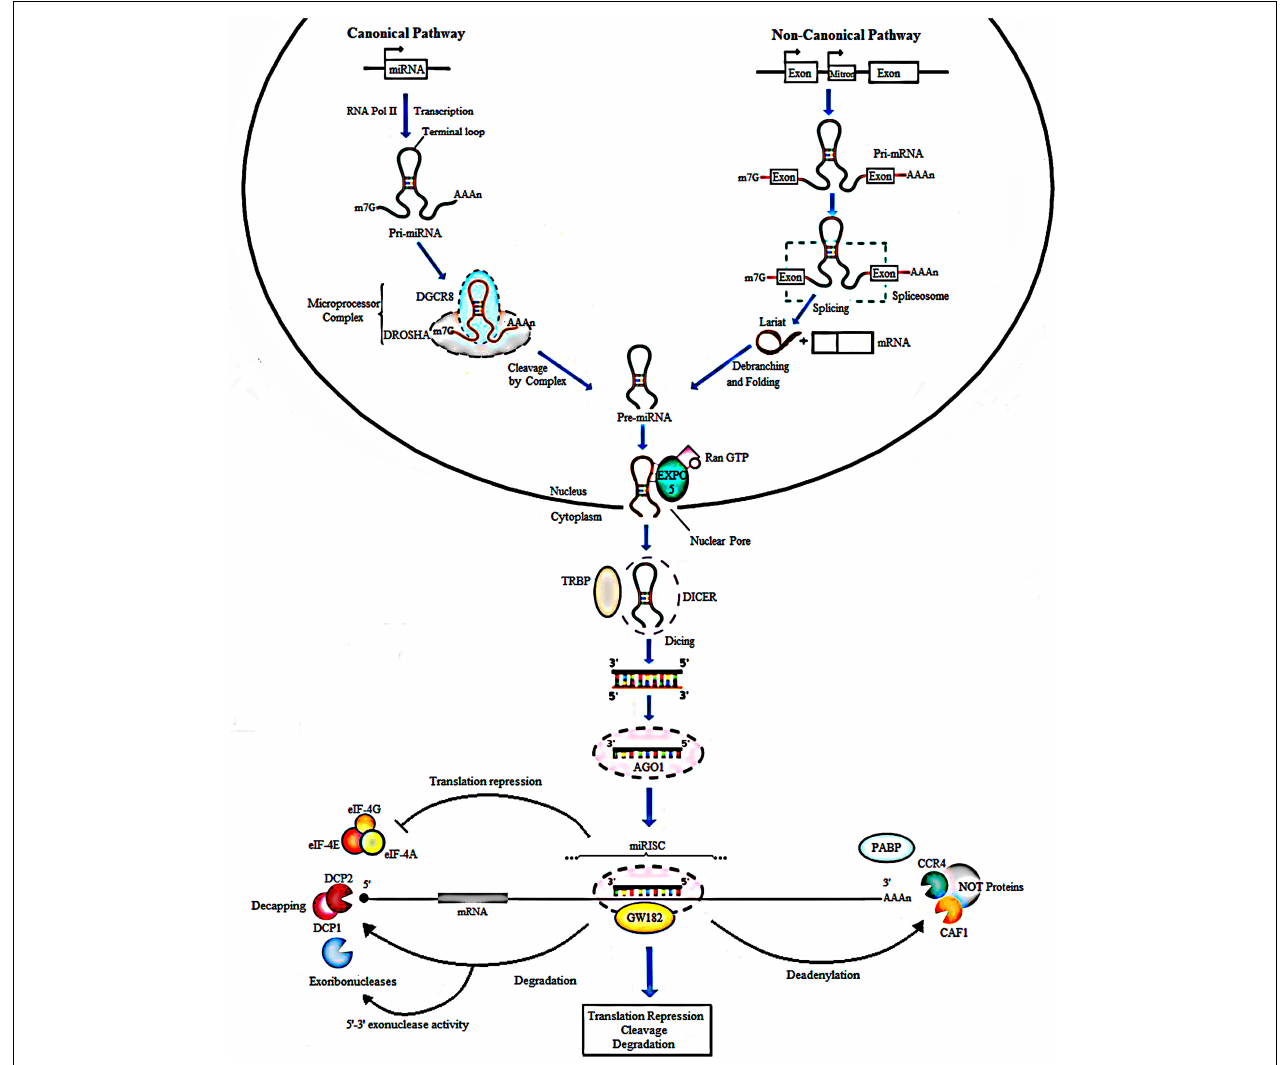
FIGURE 1 | Biogenesis of miRNAs. In the canonical pathway, miRNAs are transcribed from their loci by RNA polymerase II into a long primary transcript of about 80 nucleotides called the pri-miRNA. Cleavage follows and is done by Drosha, a type III RNase along with the DGCR8 protein to produce pre-miRNA. In the non-canonical pathway, Mirtrons are spliced by the spliceosome to form looped intermediates referred to as lariat which then refold into pre-miRNAs. Next, the exportin 5, a RAN-GTP dependent transporter, mediates the movement of pre-miRNAs from the nucleus into the cytoplasm. Further processing by Dicer and TARBP2 protein generates mature miRNAs, producing double-stranded structure of miRNA of about 21-22 nt in length. The duplex is loaded into an AGO protein. The passenger strand (miRNA ∗ ) is degraded, whereas the guide strand is incorporated by the Ago into the miRNA-induced silencing complex (miRISC). In animals, imperfect complementarity occurs when the miRNA seed region, nucleotides 2-8, BPs perfectly with the complementary seed match site in the 3 (cid:48) UTR of the target mRNA resulting in translational repression or degradation. GW182 a core component of miRISC, mediates deadenylation of mRNAs by interacting with AGO and PABP consequently leading to recruitment of deadenylases like CCR4 and CAF1. Translation repression can result from inhibited binding of PABP to the poly (A) tail of the mRNA, responsible for attracting the elFs to mRNA to initiate translation. The formation of the CCR4-CAF1-NOT complex, a poly A tail-truncating enzyme, mediated by binding of miRISC to mRNA results in truncation of the downstream poly A tail, reduced binding of translation initiation factors and translation repression. The shortening or complete removal of the poly (A) tail induces the removal of the 5 (cid:48) cap of the mRNA. Decapping is also mediated by DCP1 and DCP2. Consequently, the uncapped mRNA is rapidly degraded by 5 (cid:48) -3 (cid:48)